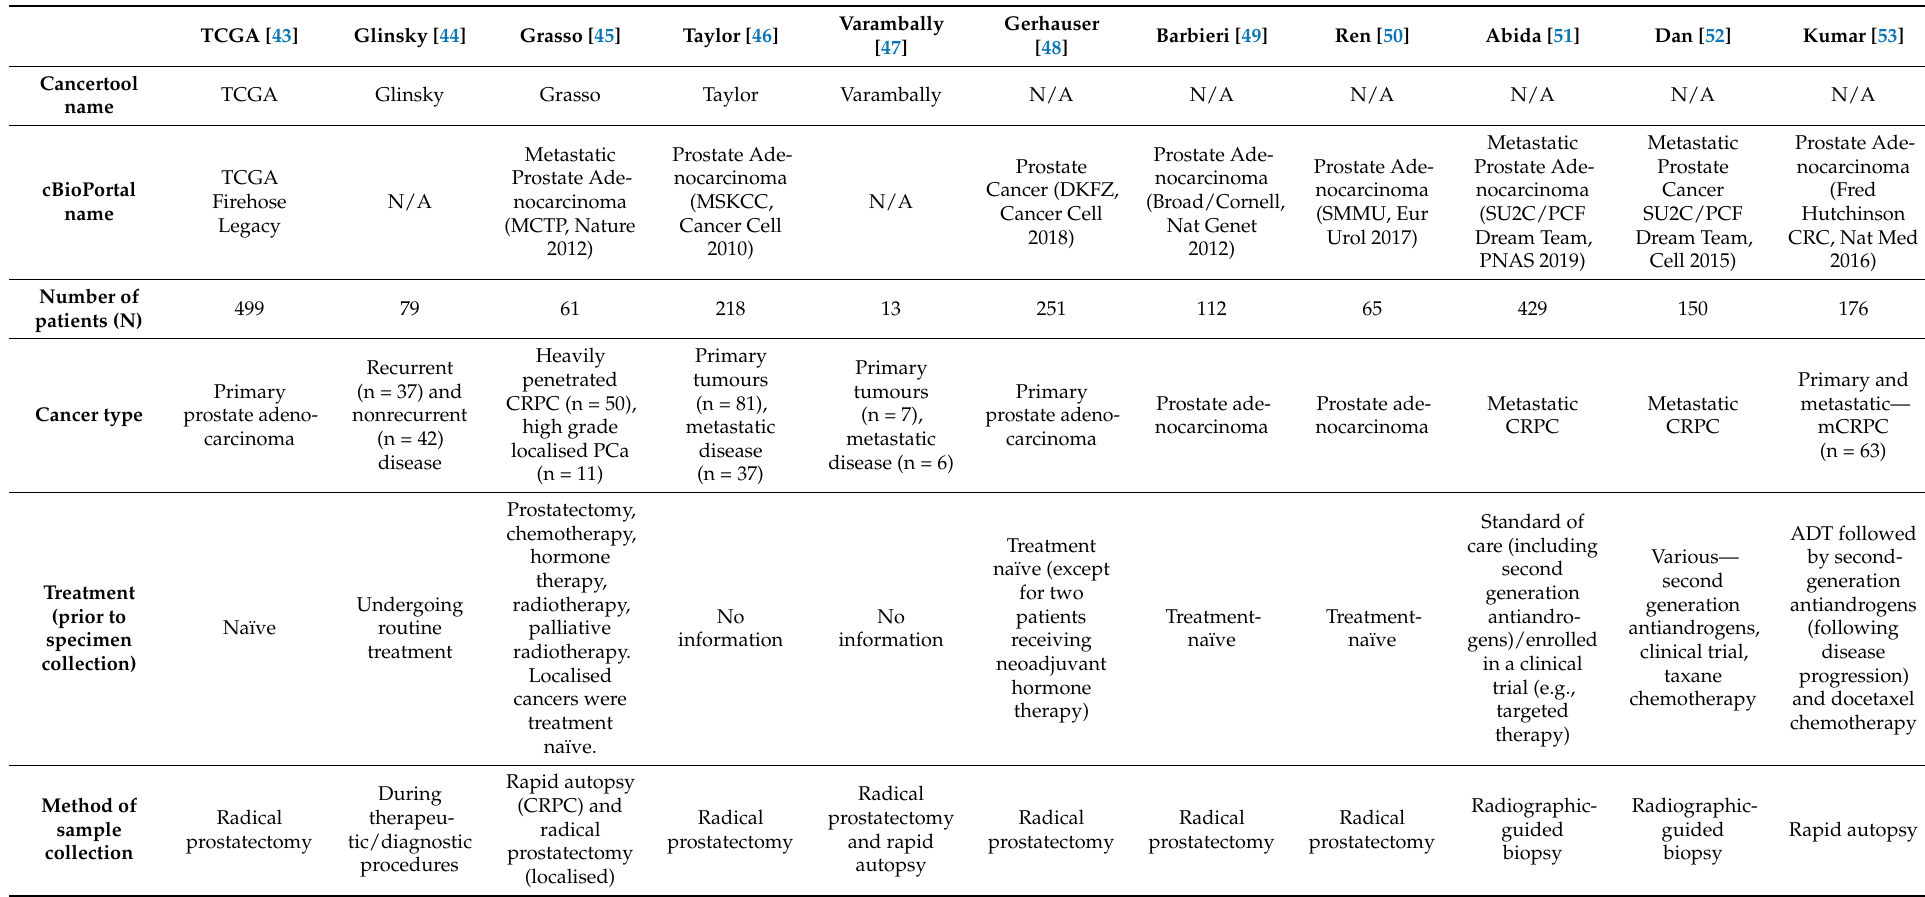
Table 1. Characteristics of human prostate cancer omics datasets investigated. Table summarising characteristics of publicly available cancer omics datasets and their patients. For each clinical attribute investigated, there was not necessarily data for each patient in the